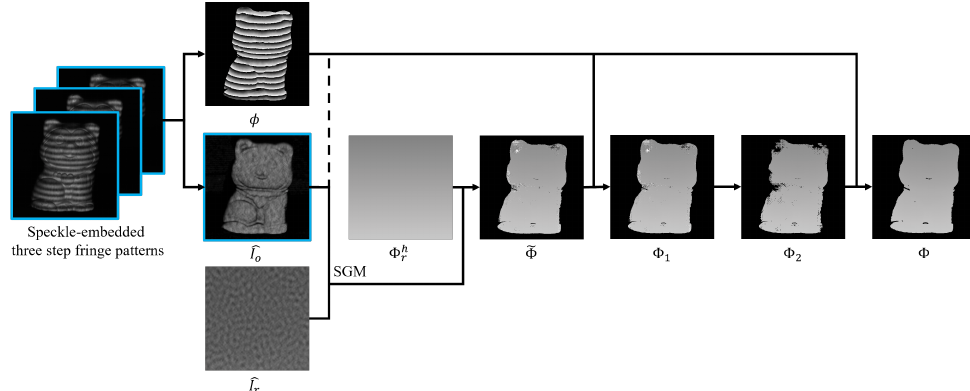
Figure 4. The overall computational framework of our proposed method.